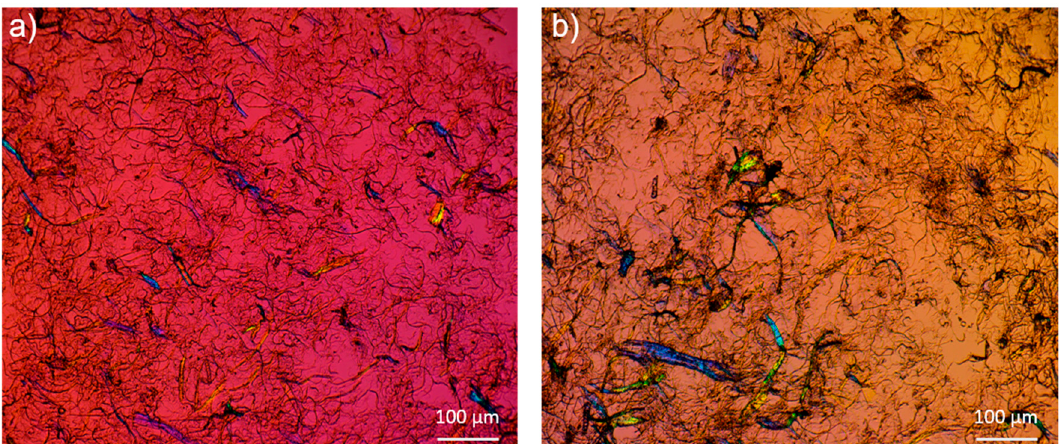
Figure 2. Microscopic images of nanofibrils under a polarized light. ( a ) Cellulose nanofibrils from bleached kraft, (CNF) and ( b ) cellulose nanofibrils from an unbleached kraft pulp, (LCNF).